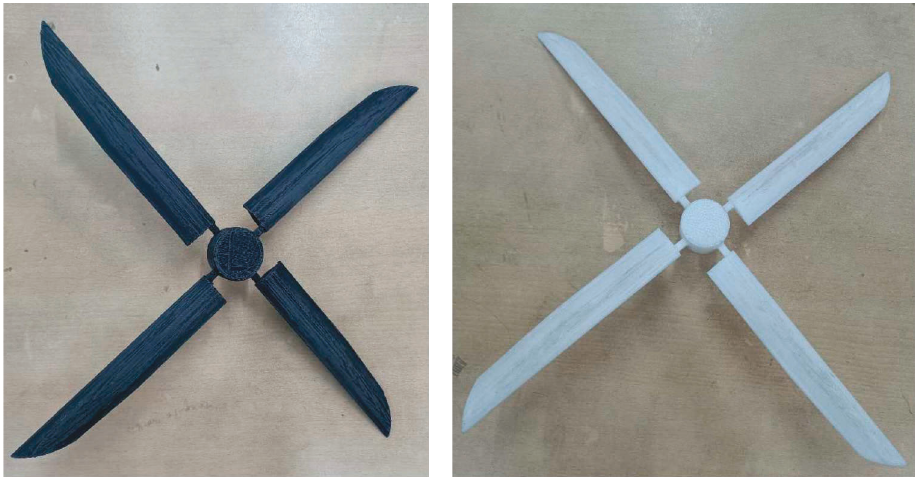
Figure 6: 3D printed models used for